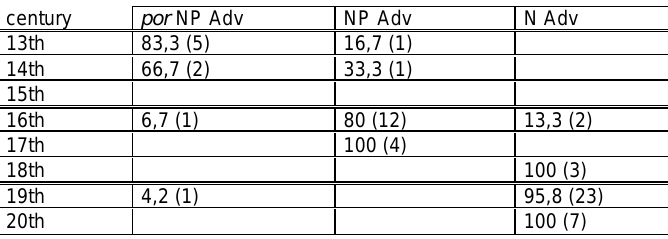
Table 4. Frequency of mar adentro ‘out to